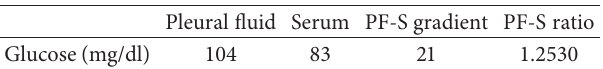
Pleural fluid Serum PF-S gradient PF-S ratio Glucose (mg/dl) 104